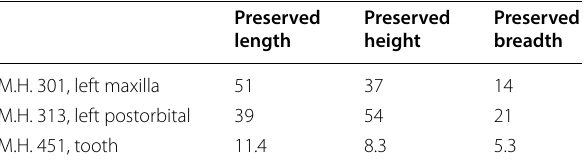
Table 3 Measurements of bones of A. greppini, and other fossil vertebrates from Moutier, Switzerland: Skull fragments